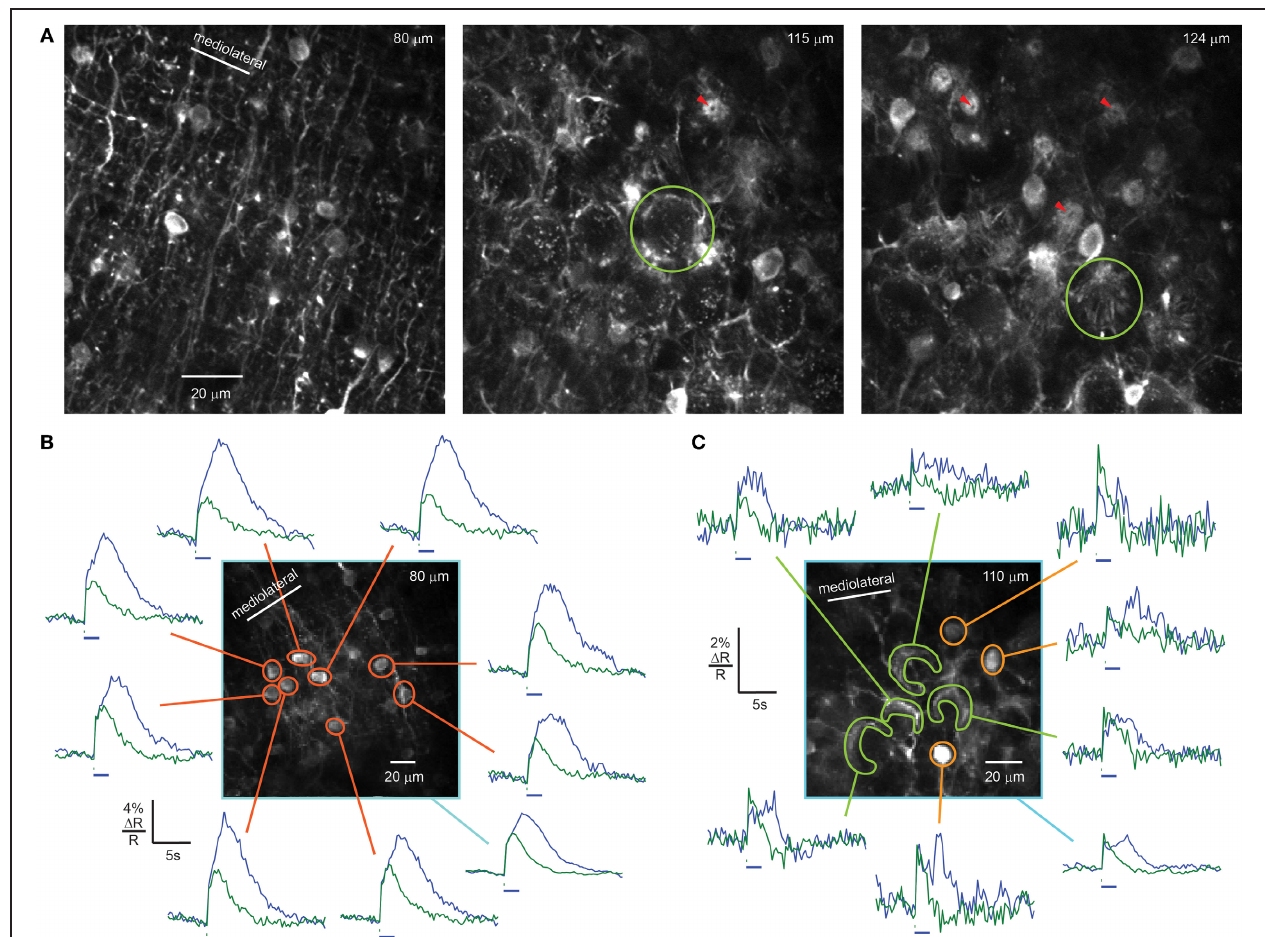
(100-ms airpuff green, 2-s airpuff blue, 48 averages) of the snout in the molecular layer. Orange masks indicate stellate cell somata 40 μ m above the PC layer. (C) In the PC layer, calcium signals from axons of basket cells can be recorded under same conditions (40 averages). Green and yellow masks indicate baskets and basket cells, respectively. The average signal of the field of view (light blue) shows similar response as single cells (B,C) . Horizontal bars, 100-ms and 2-s airpuff. Numbers in the upper right corner indicate imaging